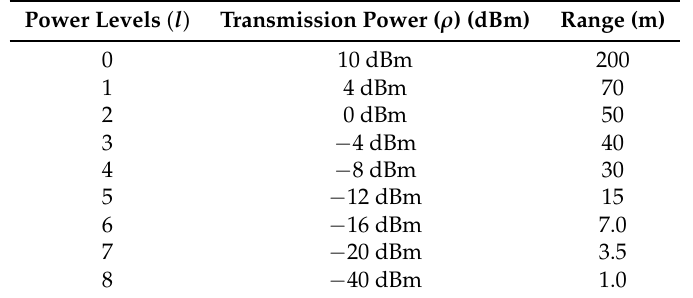
Table 1. List of transmission power levels and their transmission ranges [56] ( c (cid:13) IEEE